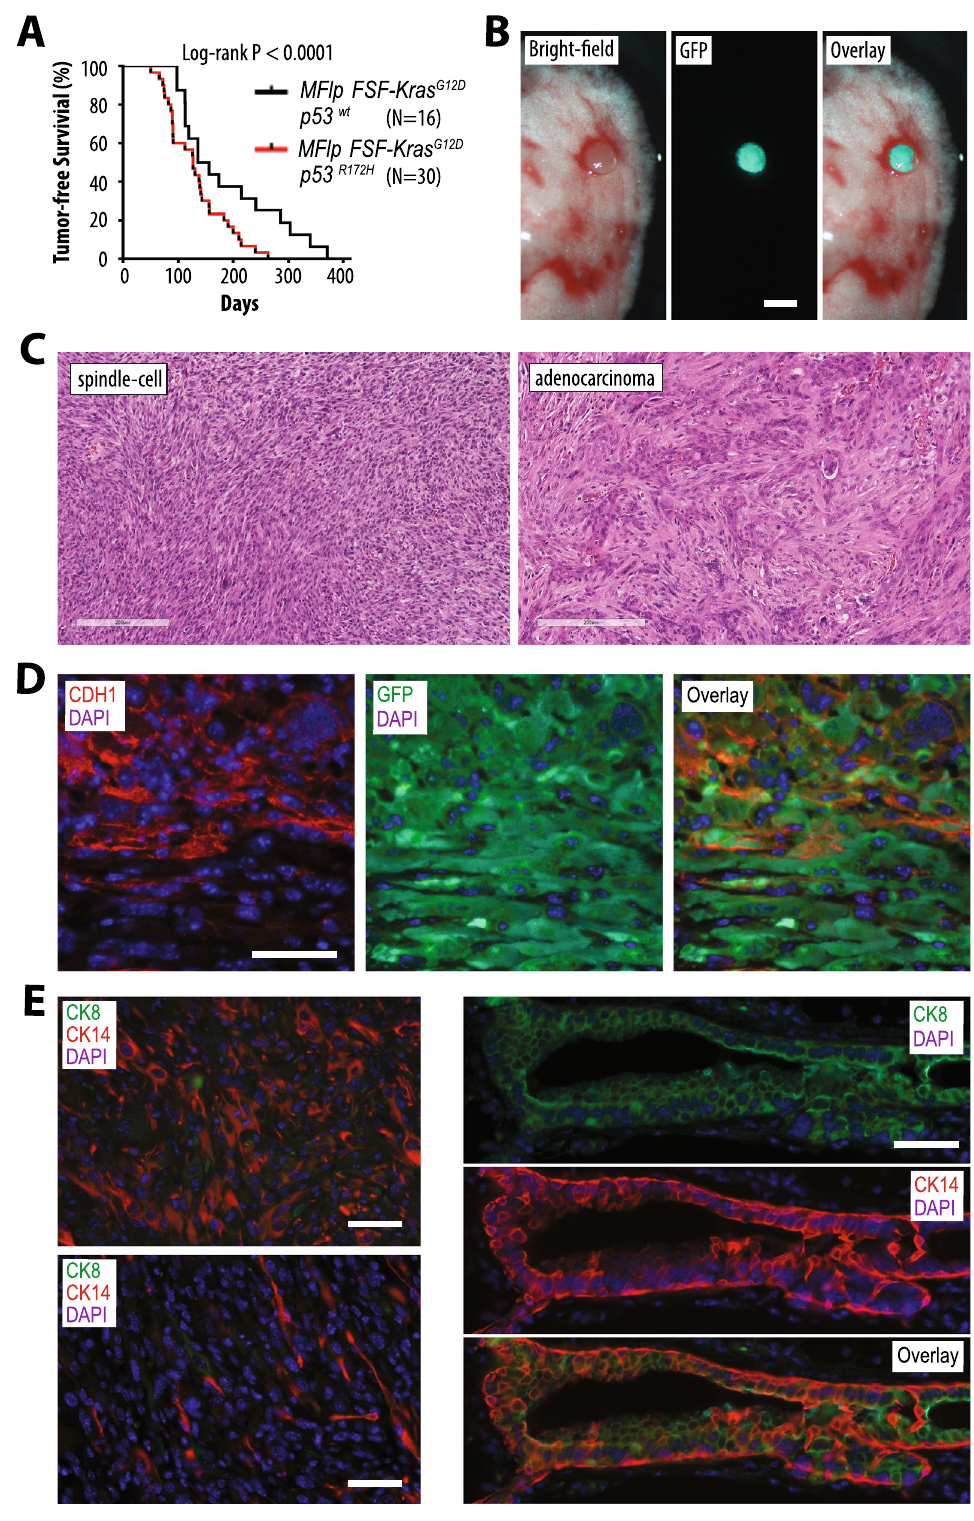
Figure 5. A single mutant p53 R172H allele leads to an earlier onset and faster malignant progression of KRAS-induced mammary cancer. ( A ) Kaplan–Meier plot comparing the tumor-free survival of females that expresses KRAS G12D in the mammary gland (MMTV-Flp FSF- Kras G12D ) with or without one mutant p53 R172H allele. Statistical significance in tumor-free survival between these experimental groups was calculated with the log-rank (Mantel-Cox) test. ( B ) Bight-field and GFP fluorescent images of the lung tissue with a GFP-positive metastatic lesion from a mammary tumor-bearing MMTV-Flp FSF-Kras G12D Rosa26 CAG-FSF-GFP p53 R172H quadruple transgenic female; bars, 1 mm. ( C ) Hematoxylin and eosin-stained histological sections of mammary cancers from MTV-Flp FSF- Kras G12D p53 R172H mice; bars, 200 µm. ( D ) Immunofluorescent (IF) staining of E-cadherin (CDH1) and GFP in a mutant p53 R172H and KRAS G12D -induced mammary tumor; bar, 50 µm. ( E ) IF staining of cytokeratins (CK) 8 (green) and 14 (red) in mammary tumors with predominantly epithelial or mesenchymal appearance (left) and a premalignant mammary duct (right); bars, 50